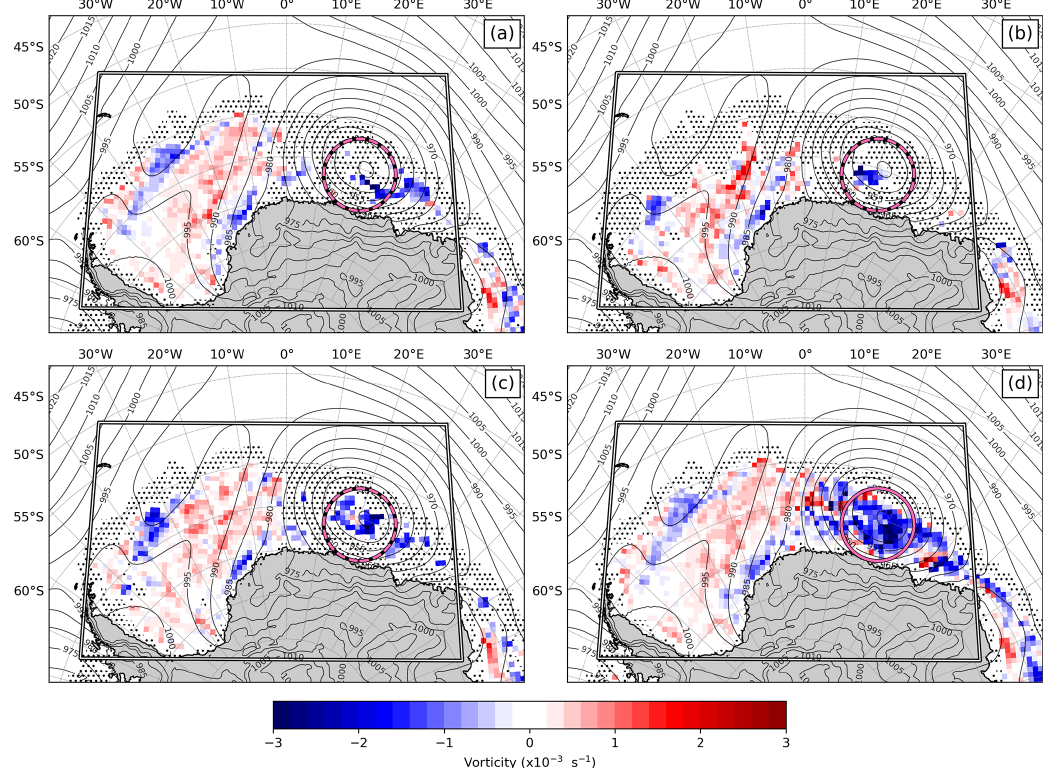
Figure 1. The sea ice vorticity field for Case study 1 between 3 July 2017, 12:00:00 and 5 July 2017, 12:00:00 (UTC) computed using the (a) AMSR-2, (b) ASCAT, (c) SSMI/S, and (d) merged ice drift products from EUMETSAT OSI SAF. Overlying contours show the 48h mean sea level pressure (MSLP) computed from hourly ECMWF-ERA5 reanalysis data over the same period. Ice drift estimates that were not considered in the vorticity computation due to their rejection flag status are shown with dotted hatching, and the rectangular box marks the area boundaries over which the algorithm described in Sect. 3 is applied. The magenta ring shows the location of the most intense cyclonic feature detected by the merged product over this 48h period, while the dashed rings indicate that the corresponding features did not meet the pixel validity threshold requirement using the AMSR-2, ASCAT, and SSMI/S